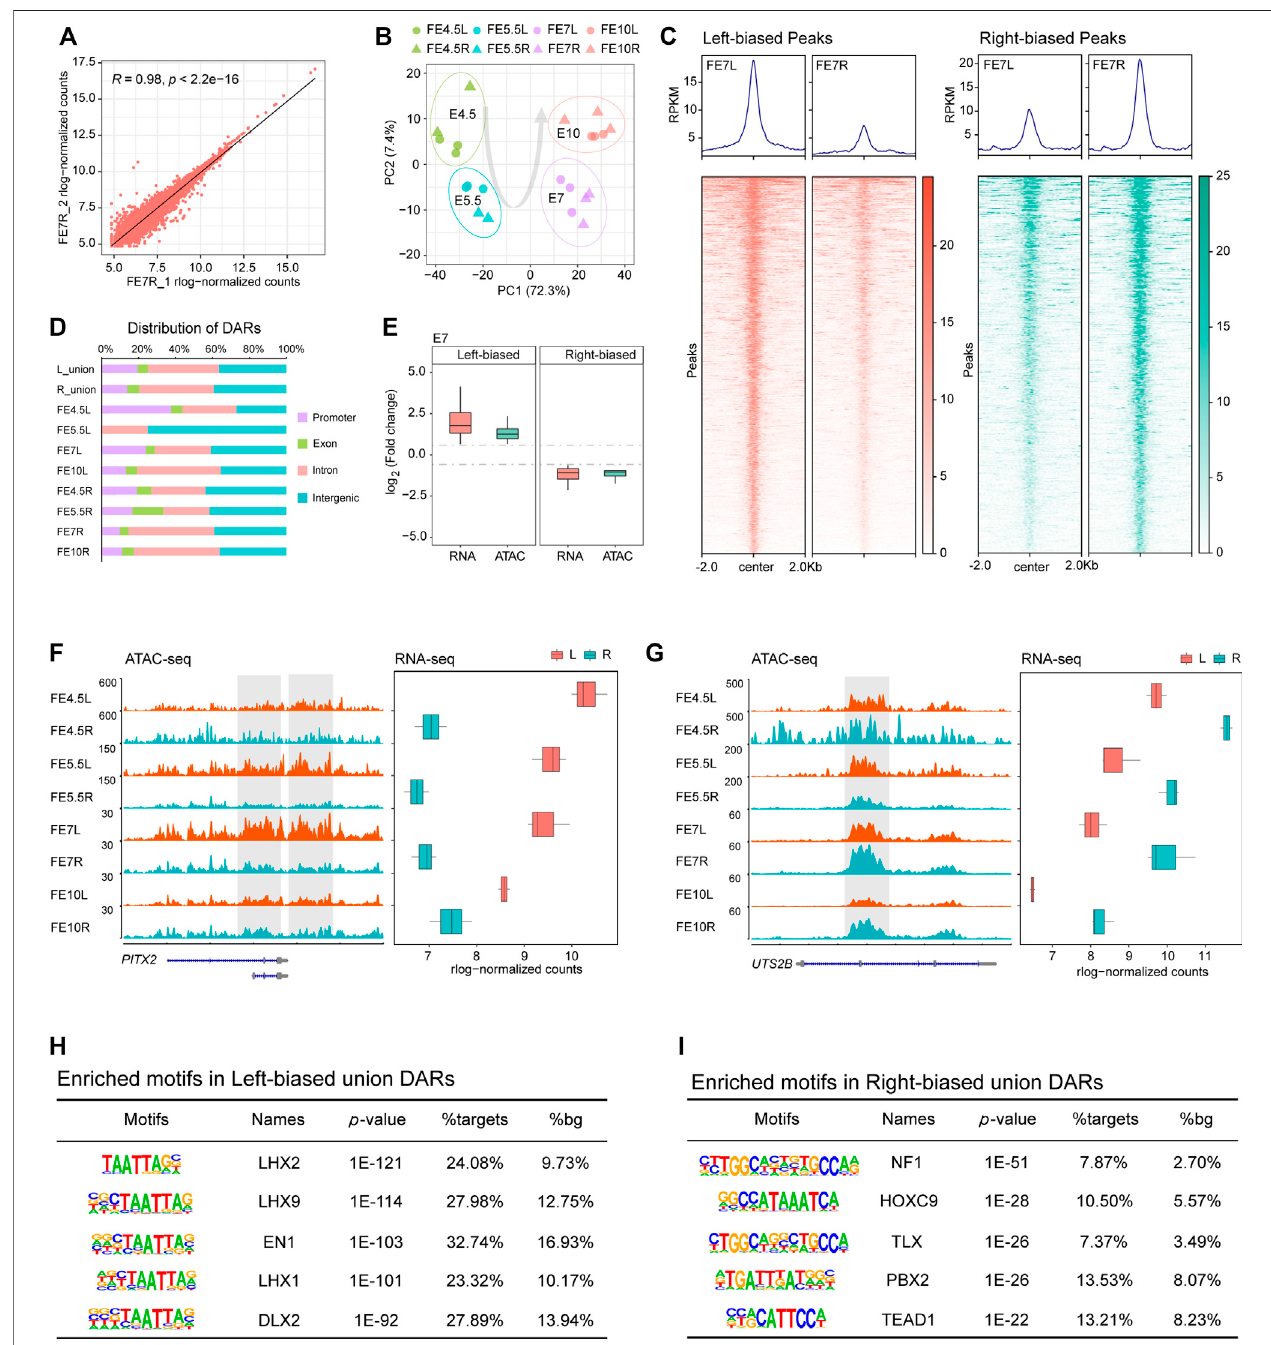
FIGURE3| Differential chromatin accessibility between the left and right gonads. (A) Scatter plots of sample correlation show high similarities among right gonad duplicates at E7; (B) PCA plot of ATAC-seq data of left and right gonads at different developmental stages; (C) Bandplots (top) and heatmaps (bottom) showing the quanti fi cation of ATAC-seq data of left-biased and right-biased signals in gonads at E7; (D) The distribution of DARs in the genome; (E) Transcriptional changes in DEGs associated with DARs between the left and right gonads; (F,G) Example of left-biased DARs and their associated DEGs (PITX2), as well as right-biased DARs and their associated DEGs (UTS2B). ATAC-seq tracks are shown in the RPKM scale. The y axis of the RNA-seq boxplot shows the embryonic day, and the x axis shows the mean rlog-normalized counts; (H) Top enriched motifs in left union peaks; (I) Top enriched motifs in right union